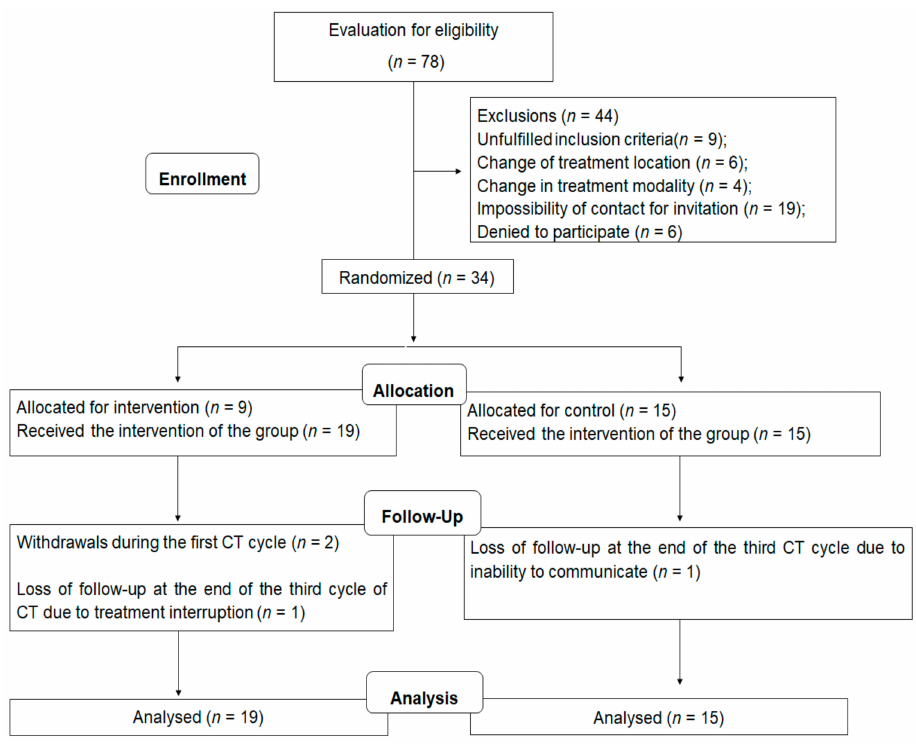
Figure 2. Flowchart of the randomized clinical